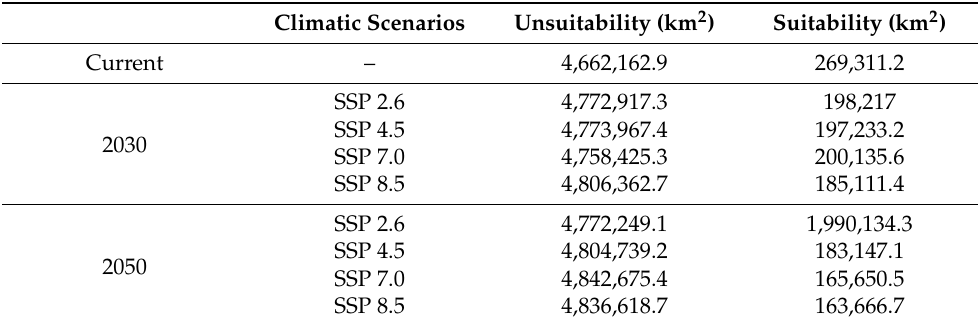
Table 7. Predicted suitable areas under the current and future climatic conditions during October– December (India).